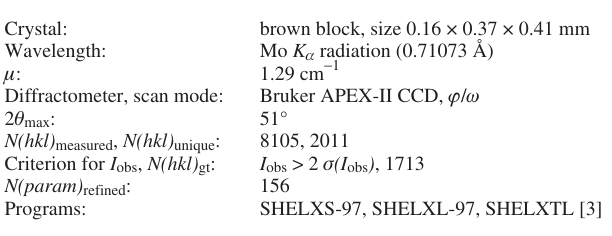
Table 1. Data collection and handling.